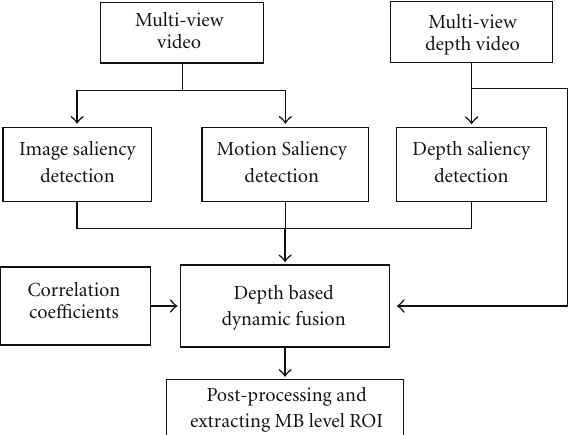
Figure 2: Flowchart of the proposed SVA-based ROI